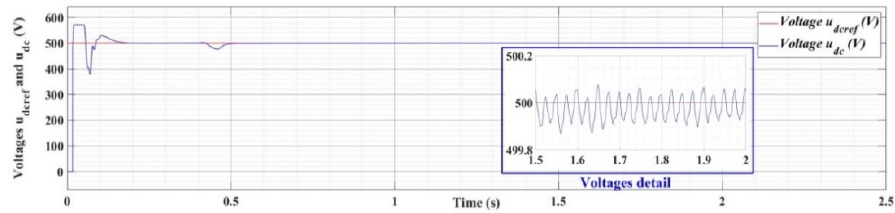
Figure 39. The time evolution of the u dc voltage for irradiance and temperature using SMC- and SYN-type controllers for a 10 kvar load (signal evolution of the type 2 PV array).